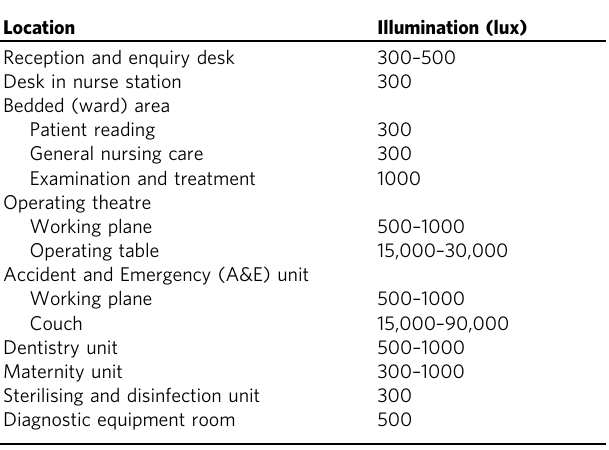
Table 1 Recommended guideline for lighting in UK healthcare